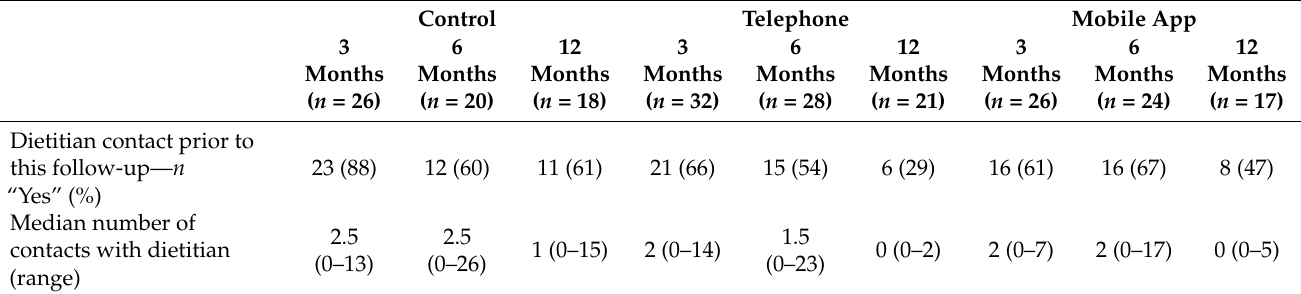
Table 2. Frequency of contact with a dietitian as part of usual care